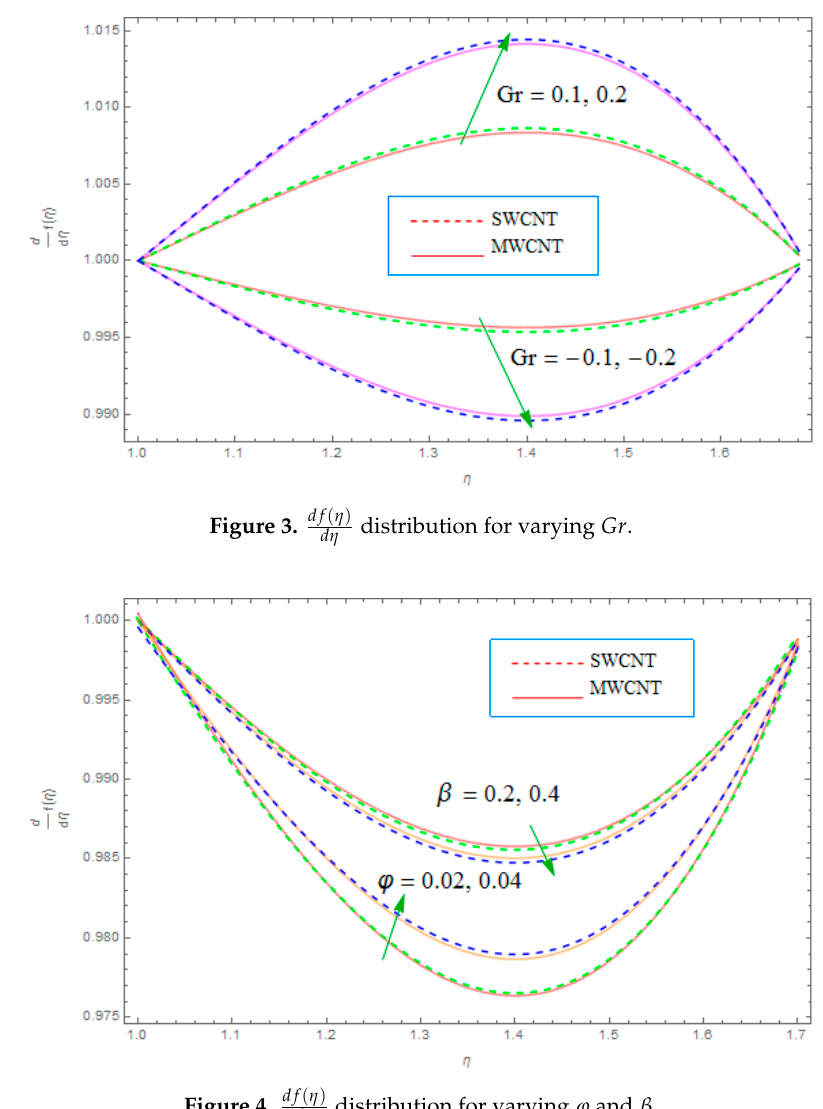
Figure 4. df ( η ) distribution for varying ϕ and β d η